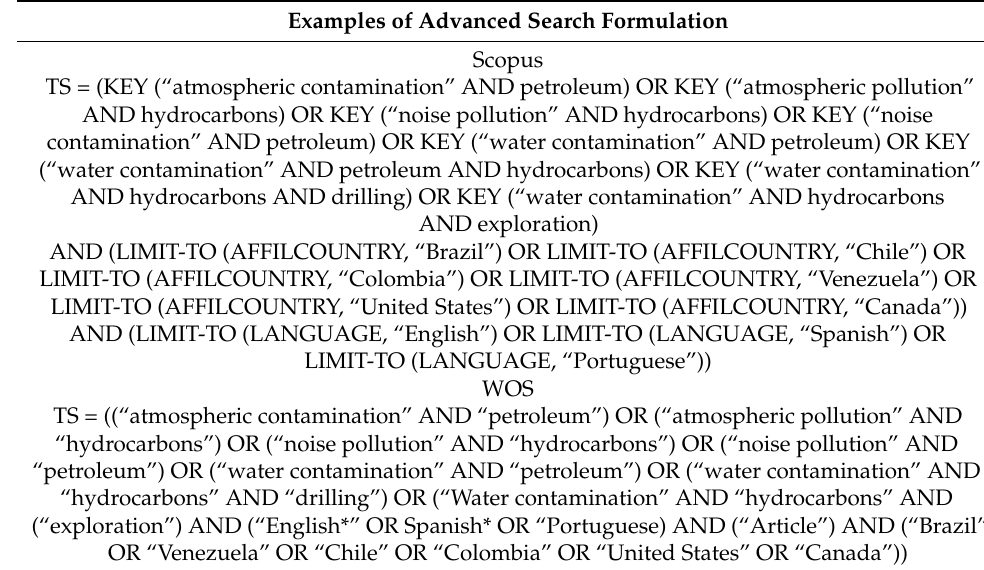
Table 2. Example of advanced search in Scopus and WOS according to selection